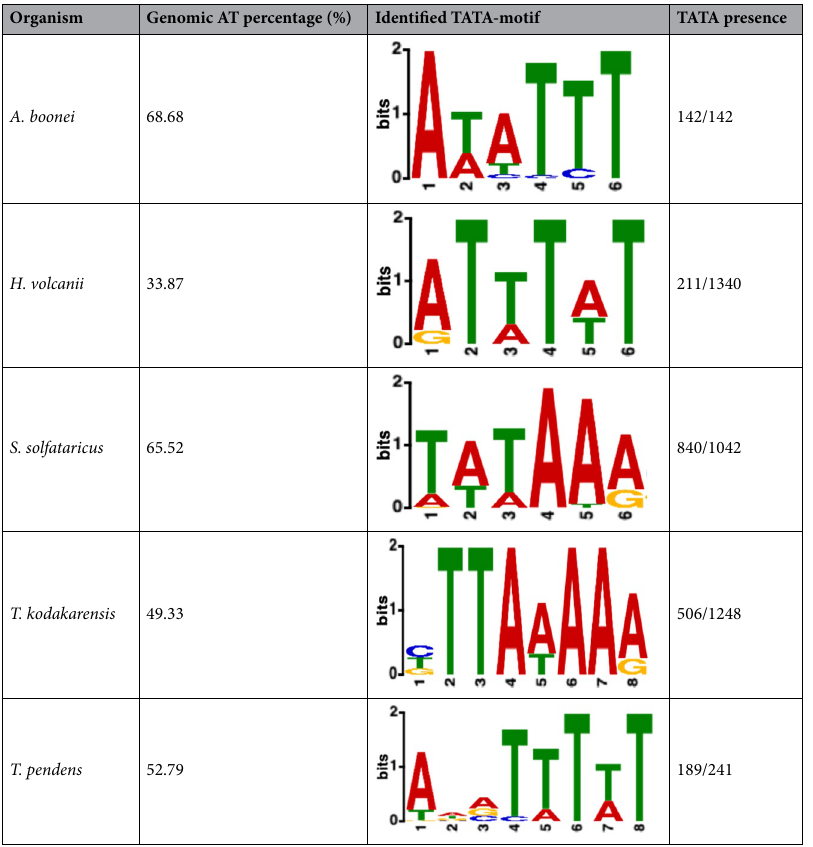
Table 1. Structural information of five distinct archaea. A general characterization of each organism in the train/test dataset is provided. The genomic AT% is accounted for. Also, through MEME (please see “Motif discovery” for details), we identified the TATA motif in the sequences of each archaeon. From the motif returned, we scanned the sequences and checked the proportion of promoters that contain a canonical TATA motif as identified by MEME.